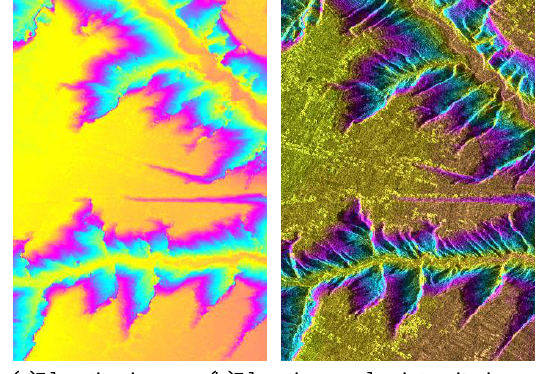
Figure 9. Elevation image of local